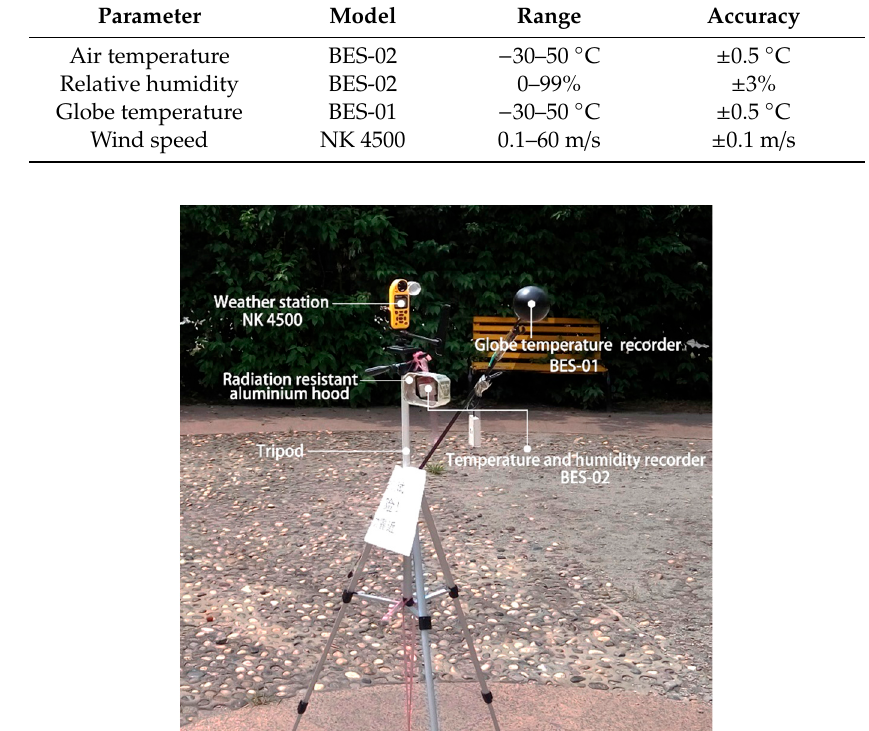
Table 2. The meteorological data of the measured days in different seasons.